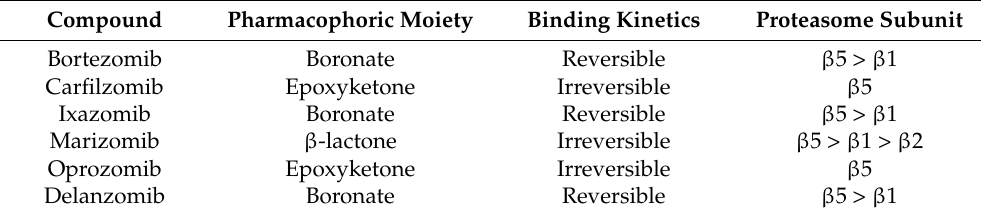
Table 1. Name, pharmacokinetics and pharmacodynamics characteristics of proteasome